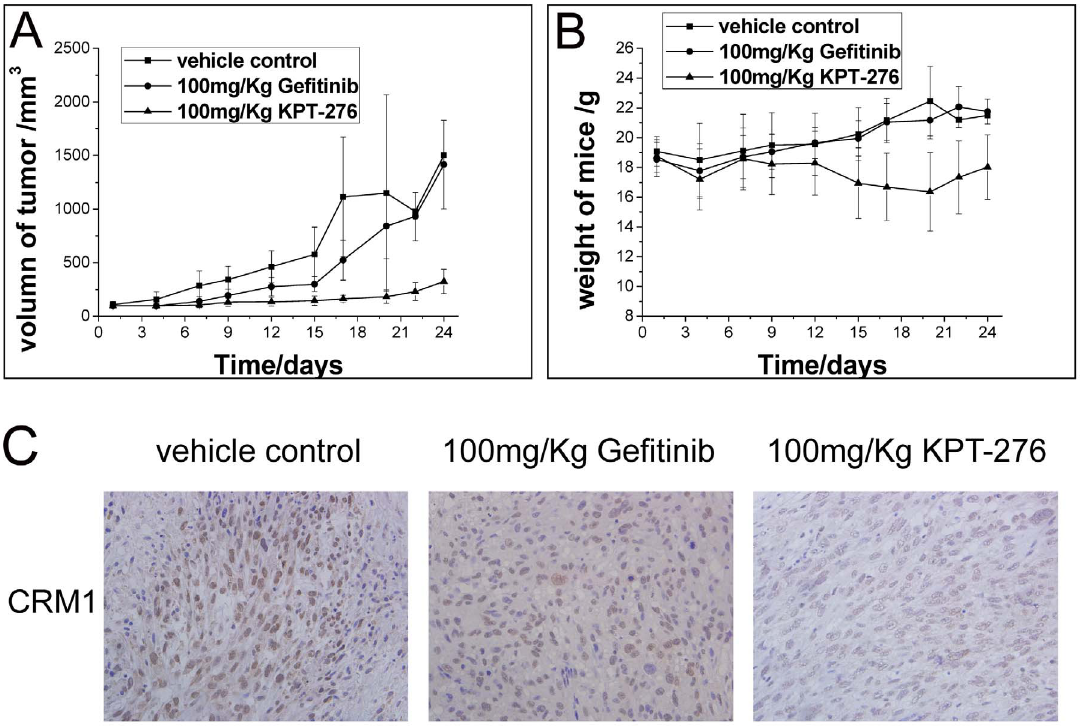
Figure 6. Effects of KPT-276 on mouse H1975 cell xenograft growth inhibition. NSCLC H1975 cells were transplanted into NOD-SCID mice. Mice with an established NSCLC cell xenograft were orally administered with vehicle, gefitinib, or KPT-276. Tumor cell xenograft growth was assessed for 30 days. Tumor growth curves showed a statistically significant suppression of H1975 cell growth in vivo when compared to vehicle or gefitinib treatment ( P , 0.05; A). Mice administered oral KPT-276 (100 mg/kg, three times a week for three weeks) tolerated the treatment well (B). The protein level of CRM1was detected in xenograft tumors by immunohistochemistry (C, 400 6 ).